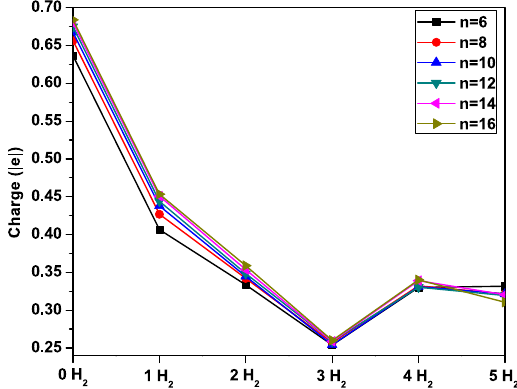
Figure 9. Li atomic charge for Li 2 B n ( n = 6, 8, … , and 16) with x H 2 molecules ( x = 0–5) adsorbed on each Li, obtained with TAO-BLYP-D. Here, the CHELPG scheme is employed to calculate the Li atomic charge.